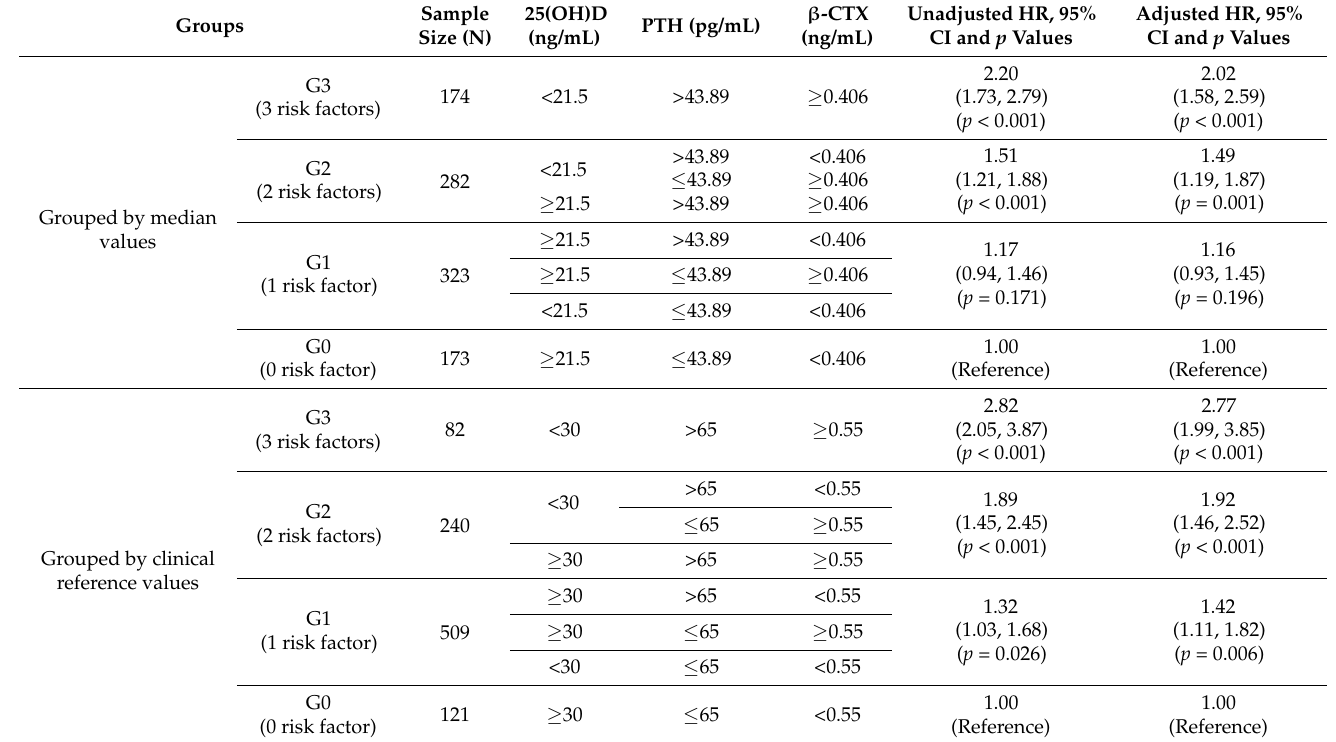
Table 3. Cox regression analyses for the associations of all-cause mortality with the combined risk factors of low 25(OH)D, high PTH and β -CTX levels in